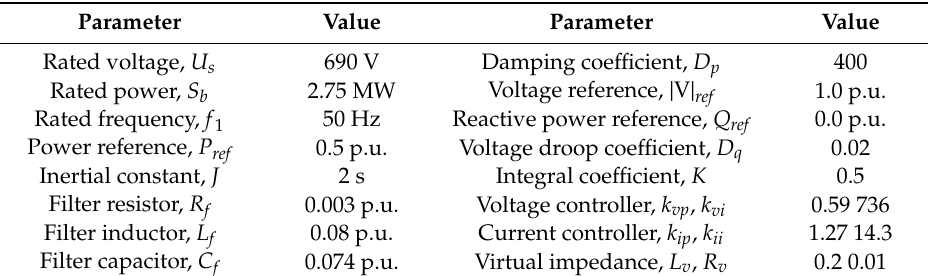
Table 1. Parameters of VSG controlled converter system.